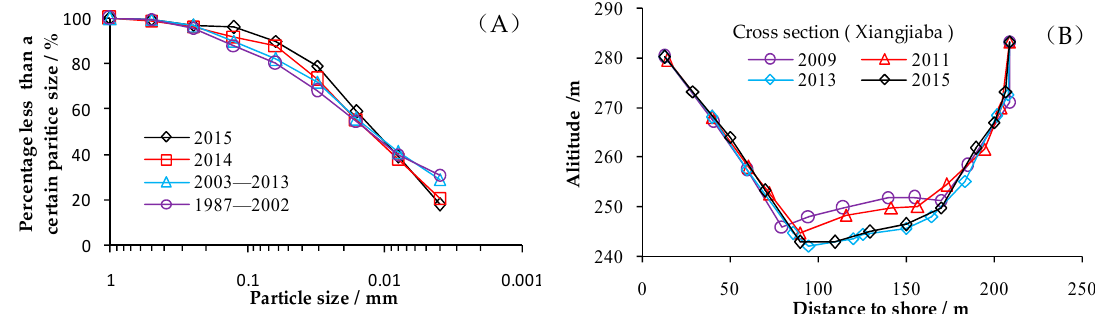
Figure 5. Results of downstream channel erosion change in response to sediment reduction ( A : Changes of sediment particle size in the Pingshan Station; B : Changes of topography in the Xiangjiaba cross section).